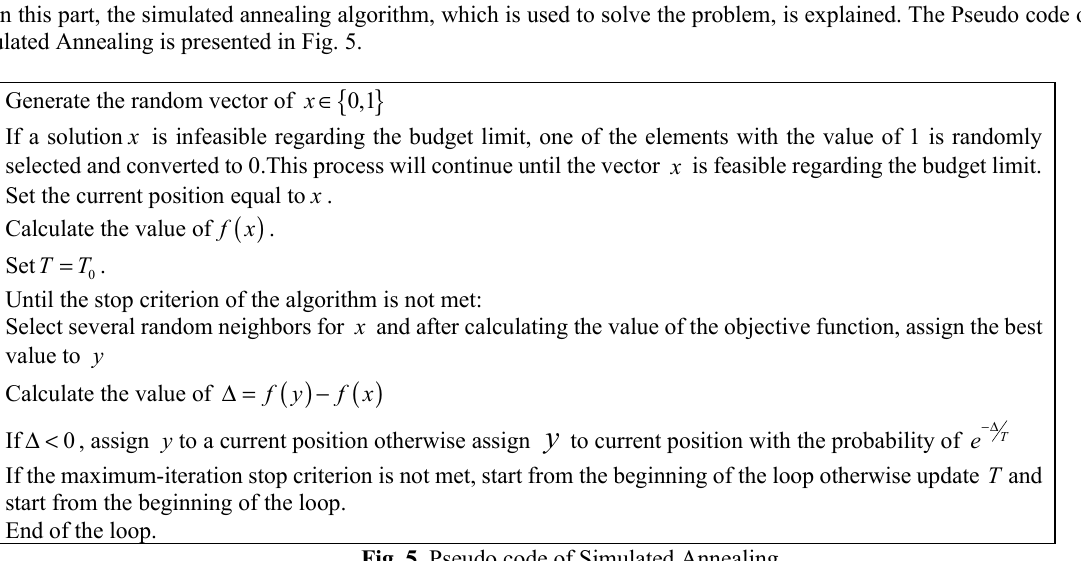
Fig. 5. Pseudo code of Simulated